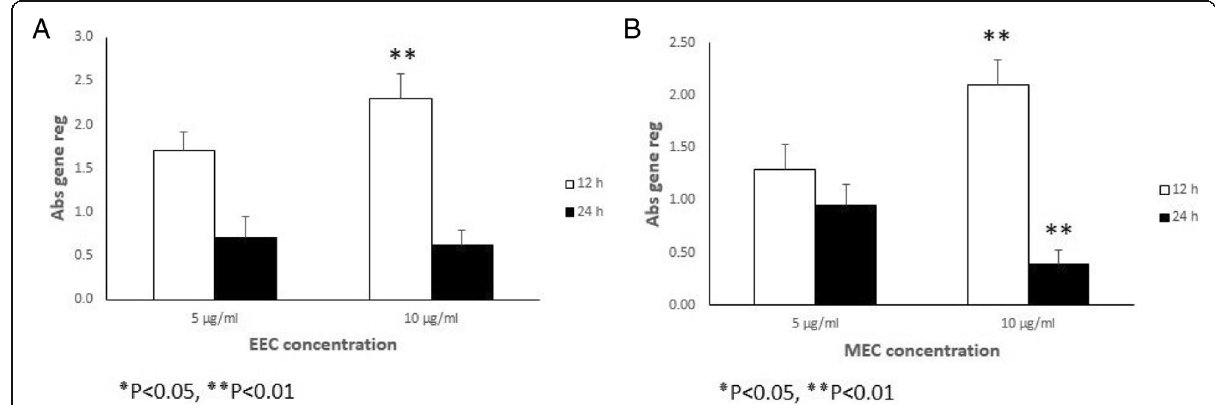
Fig. 2 Relative expression of TGF β 1 gene in the MEFs that were treated with various concentrations of ethanol ( a ) and methanol ( b ) extracts of Calendula at different time intervals treatment (12 and 24 h). All comparisons were made compared to the control group. * P < 0.05, ** P < 0.01. Abs gene reg: Absolute gene